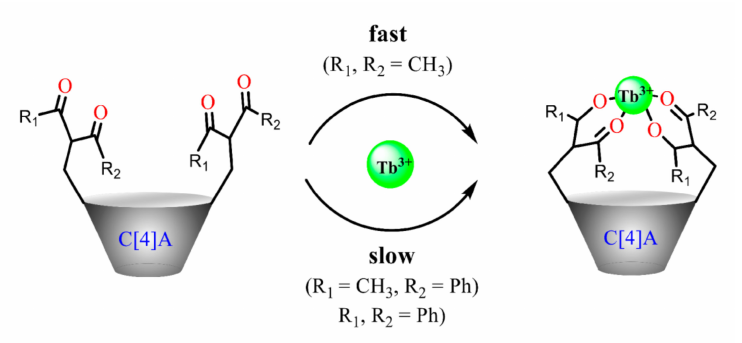
Figure 5. Cartoon illustration of the substituents effect on the complex formation of 1,3-diketone calix[4]arenes with Tb 3+ Reproduced from Ref. [55] with permission from the Elsevier, the Centre National de la Recherche Scientifique (CNRS) and the Royal Society of